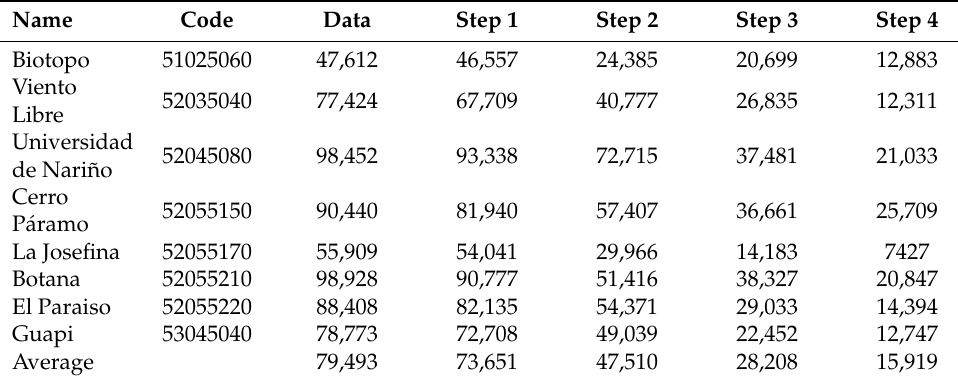
Table 6. Solar irradiance validation results. Each step represents the amount of data that overcome the validation level.